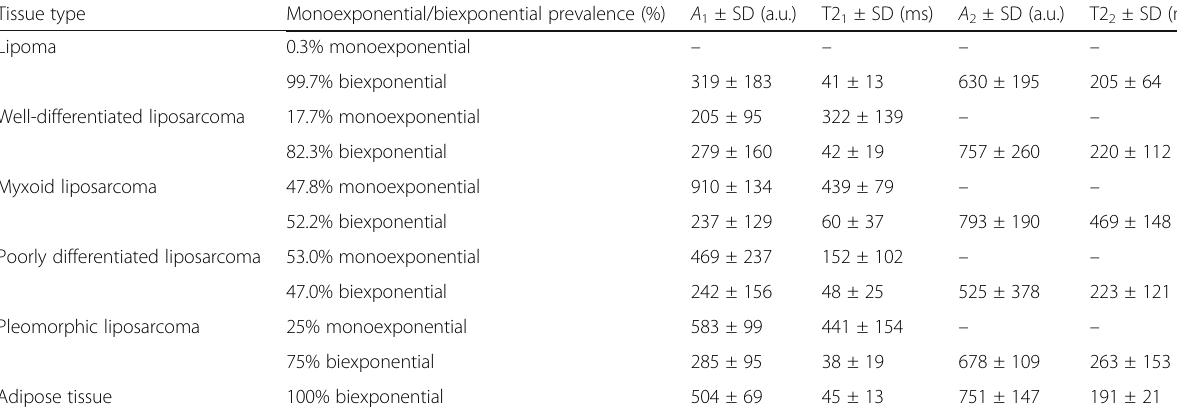
Table 1 Multiexponential T2 analysis